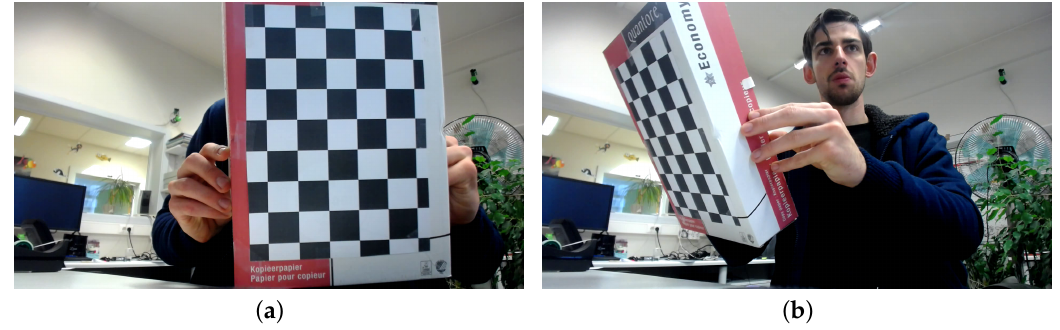
Figure 4. Two examples from the captured training data set, ranging from clean front-view images ( a ) to oblique vantage points ( b ).